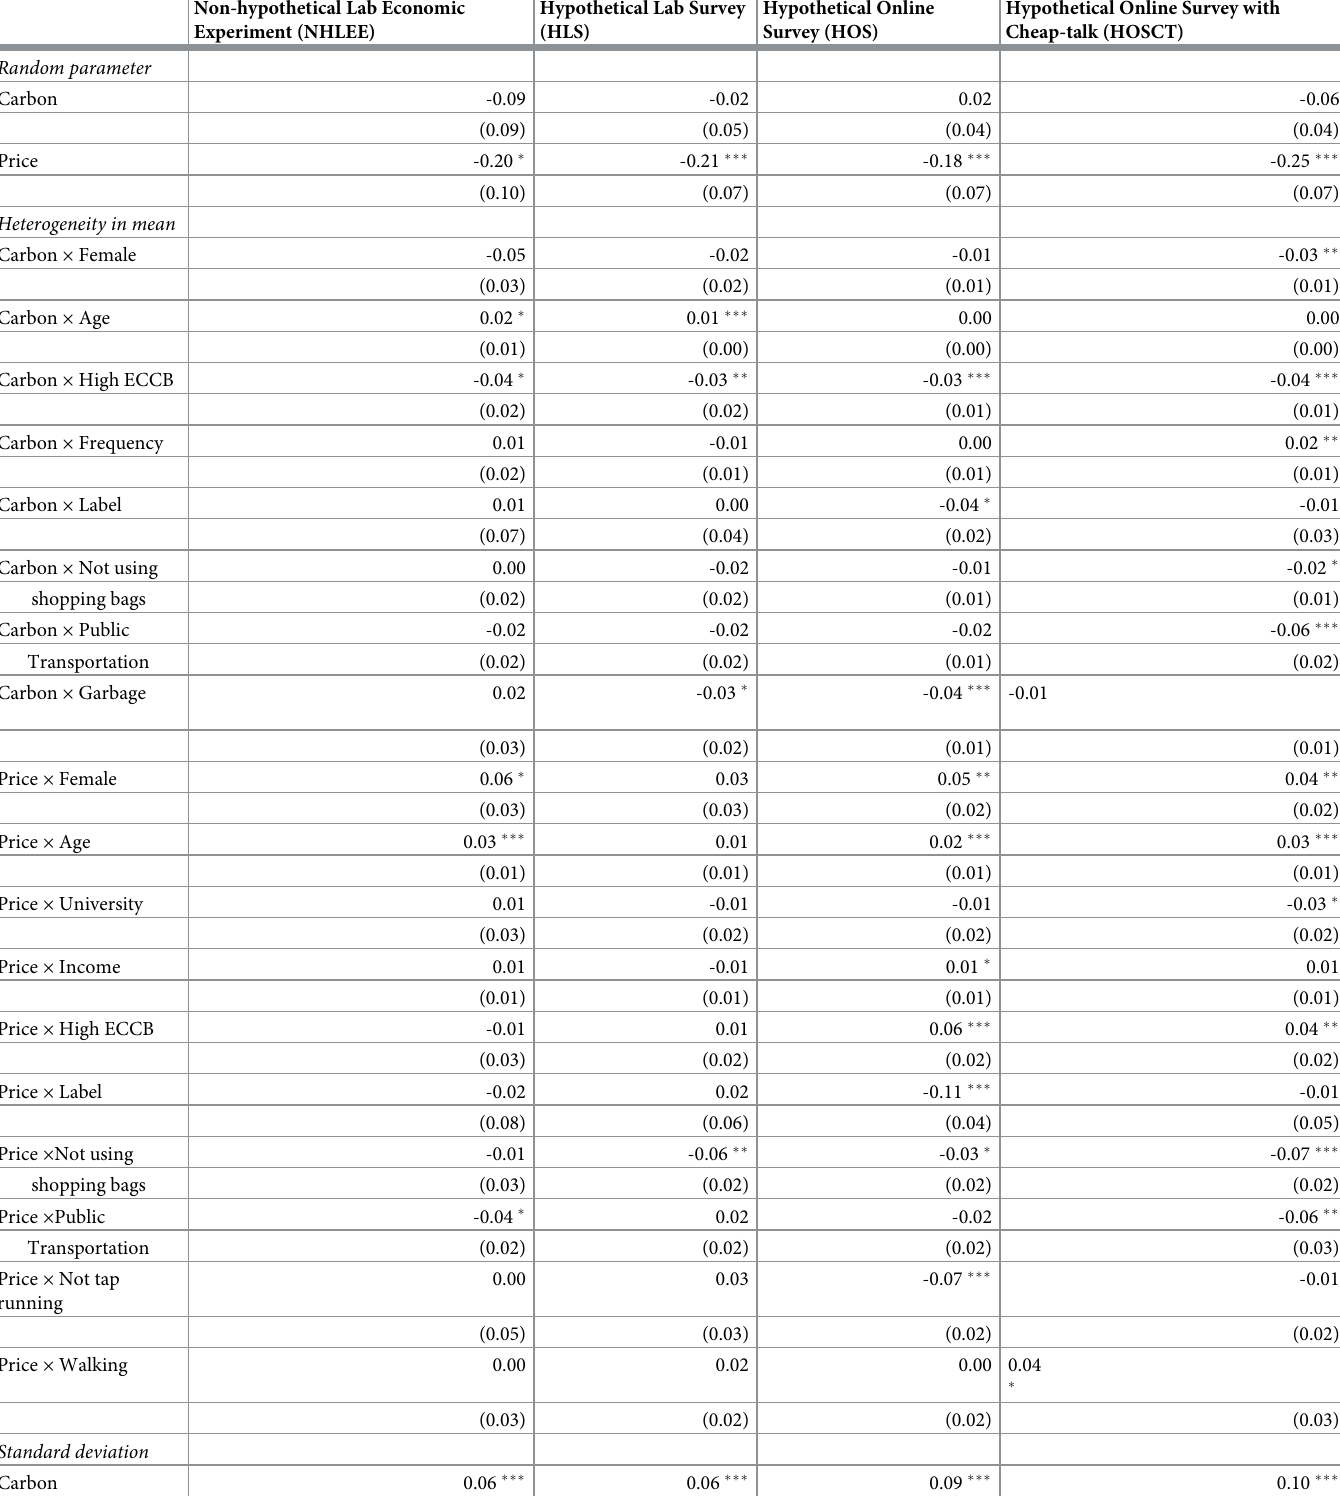
Table 6. The RPL estimation results in the main effect with interaction (Model 2) (Only significant